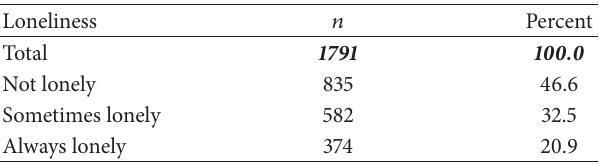
Table 2: Percentage and frequency distribution of respondents by levels of